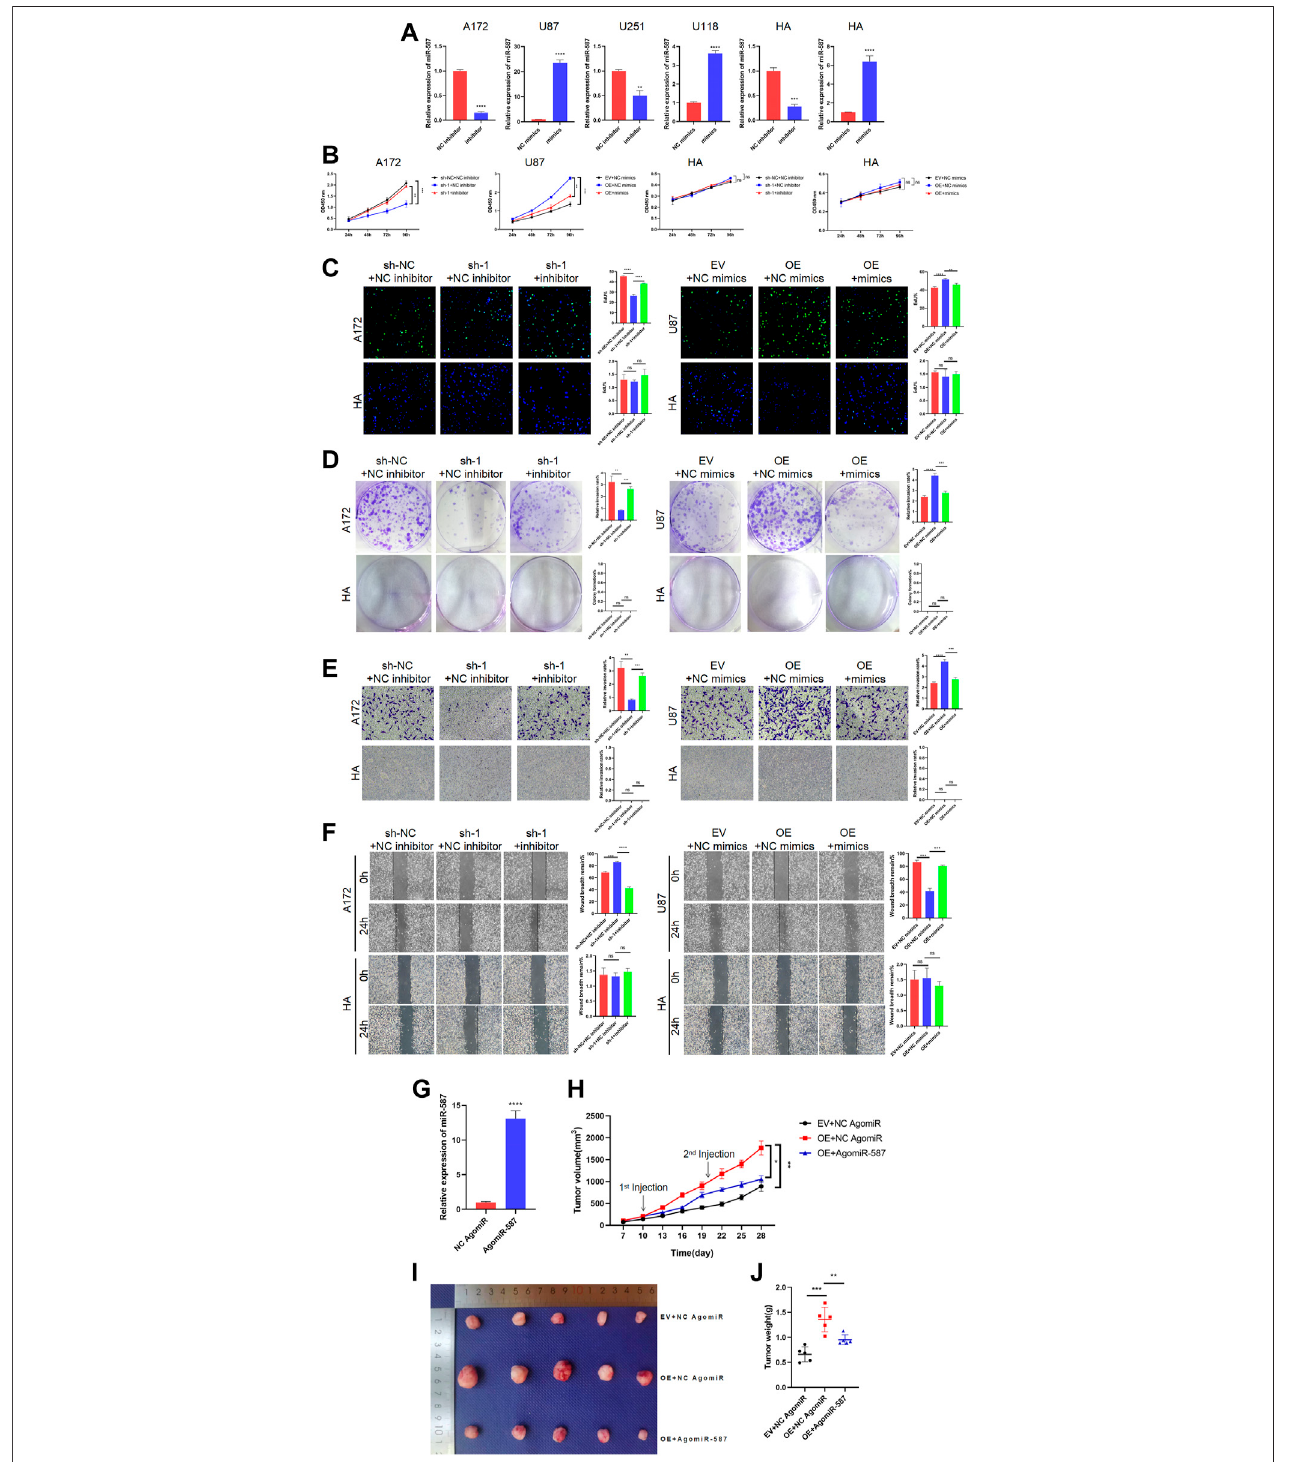
FIGURE5| circRFX3 enhanced themalignantbehaviorofglioblastoma (GBM)cells bysuppressingmiR-587 invitro and invivo . (A) miR-587 mimics increasedthe miR-587 expression, while miR-587 inhibitor decreased the miR-587 expression in GBM cells and human astrocytes (HAs). (B – D) CCK-8, EdU, and colony formation experiments demonstrated that the circRFX3-sponging effect on miR-587 partially rescued the proliferation inhibition caused by circRFX3 depletion in A172 cells, whereas the promotion of cell proliferation led by circRFX3 overexpression in U87 cells was reversed by increasing miR-587. However, the knockdown or overexpressionofmiR-587hadnoeffectonHAs. (E,F) Theresultsoftranswellinvasionandwound-healingassaysshowedthatthemiR-587inhibitorpartiallyattenuated